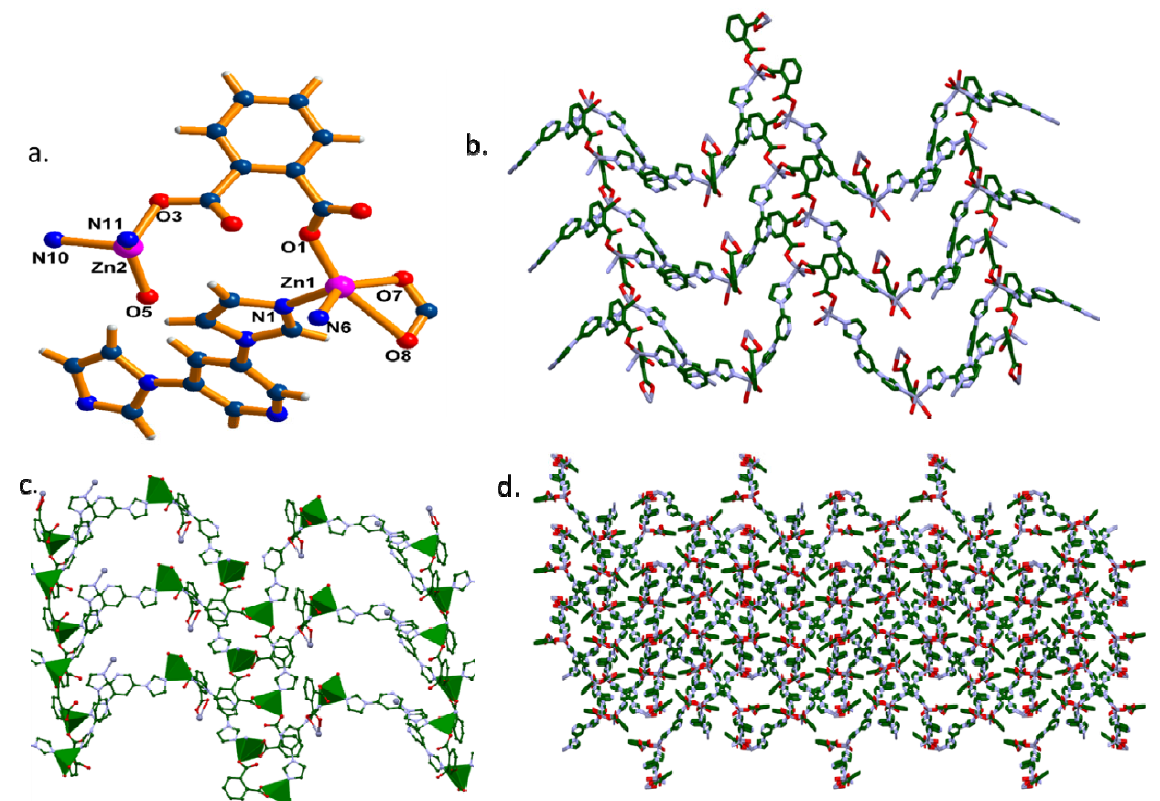
Figure 2. Schematic representations of the crystal structure of 2 . ( a ) The coordination environment of the Zn(II) ions. ( b ) Depiction of the bilayer structure containing 1D channels in 2 along the a ‐ axis. ( c ) The connectivity between the Zn clusters, dib, and 1,2 ‐ bdc units, forming a 2D arrangement. ( d ) Packing structure along the b ‐ axis.